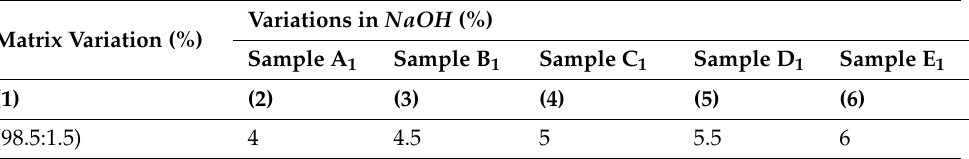
Table 3. Experimental design for various NaOH polymer composite materials with a variety of C 2 sample matrices as a reference.